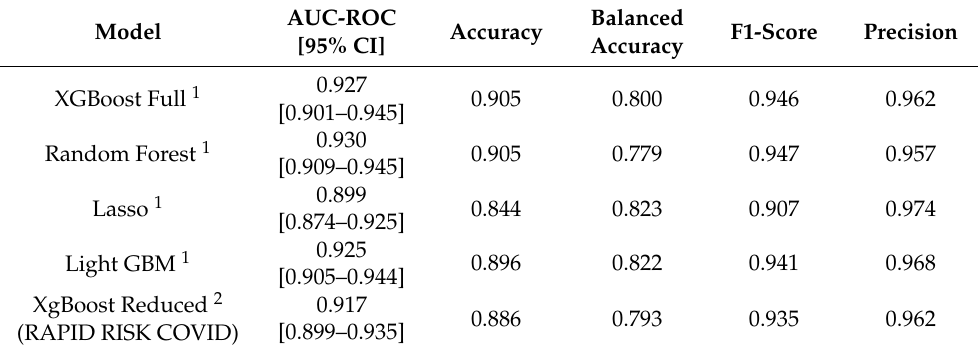
Table 4. Results of model performance in predicting hospitalization in patients with respiratory symptoms during the COVID-19 pandemic. The predictions were retrieved in the test set ( n =